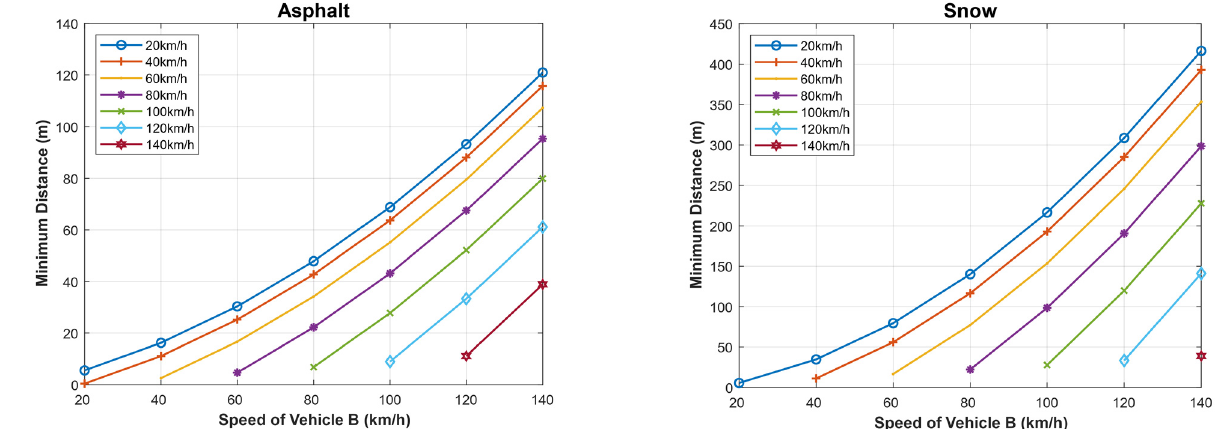
Figure 16. Minimum safe driving distance for different speeds of both the following and the followed vehicle in the case when the weather is clear, assuming the driver reaction time is 1 s for dry asphalt and snowy roads.